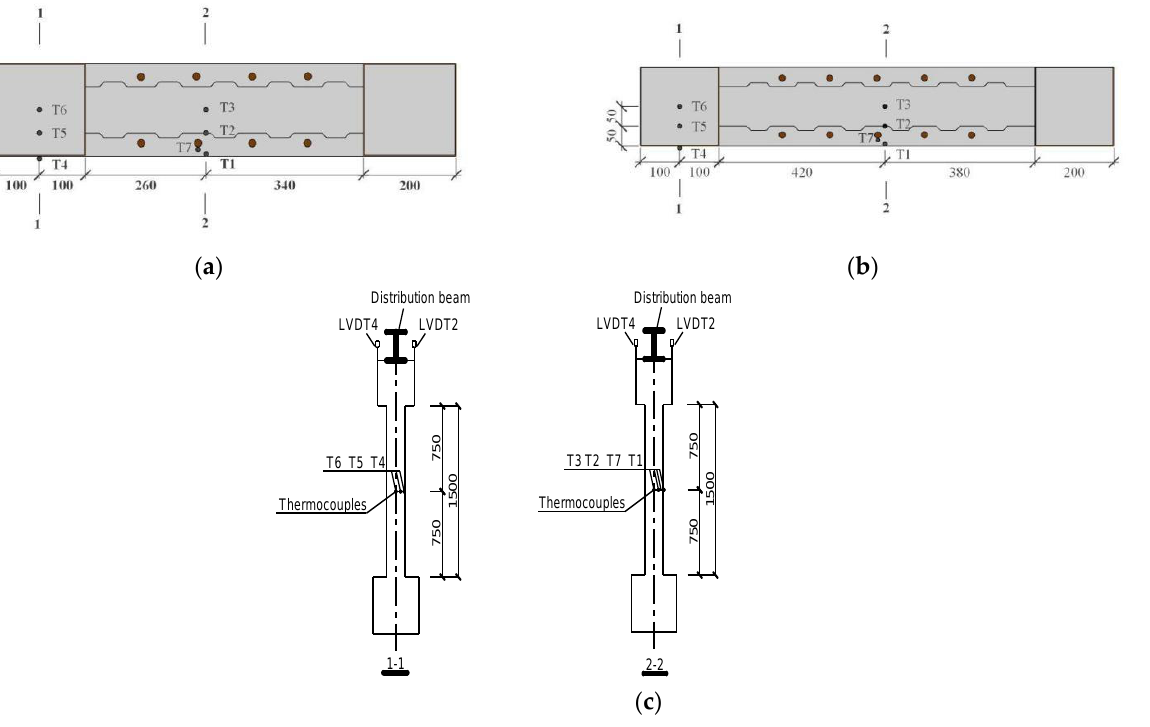
Figure 7. Arrangement of thermocouples in specimens (unit: mm). ( a ) Arrangement of thermocouples in SW2 and SW3; ( b ) Arrangement of thermocouples in SW4; ( c ) Thermocouples side profile.